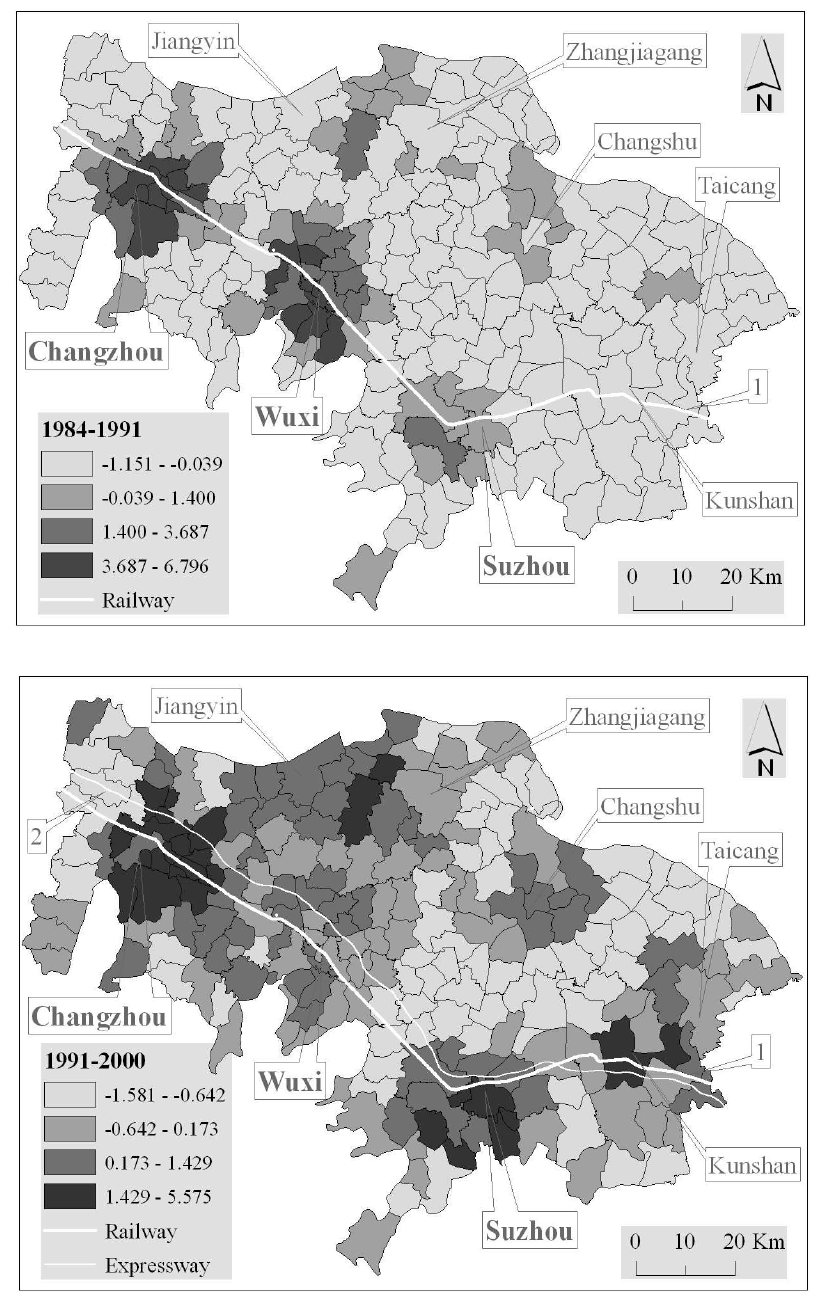
Figure 10. Spatial distribution of the local Getis-Ord G ; 1 denotes Huning railway, 2 Huning expressway, 3 Subei railway, 4 Xicheng expressway, 5 Yanjiang expressway, and 6 Sujiahang